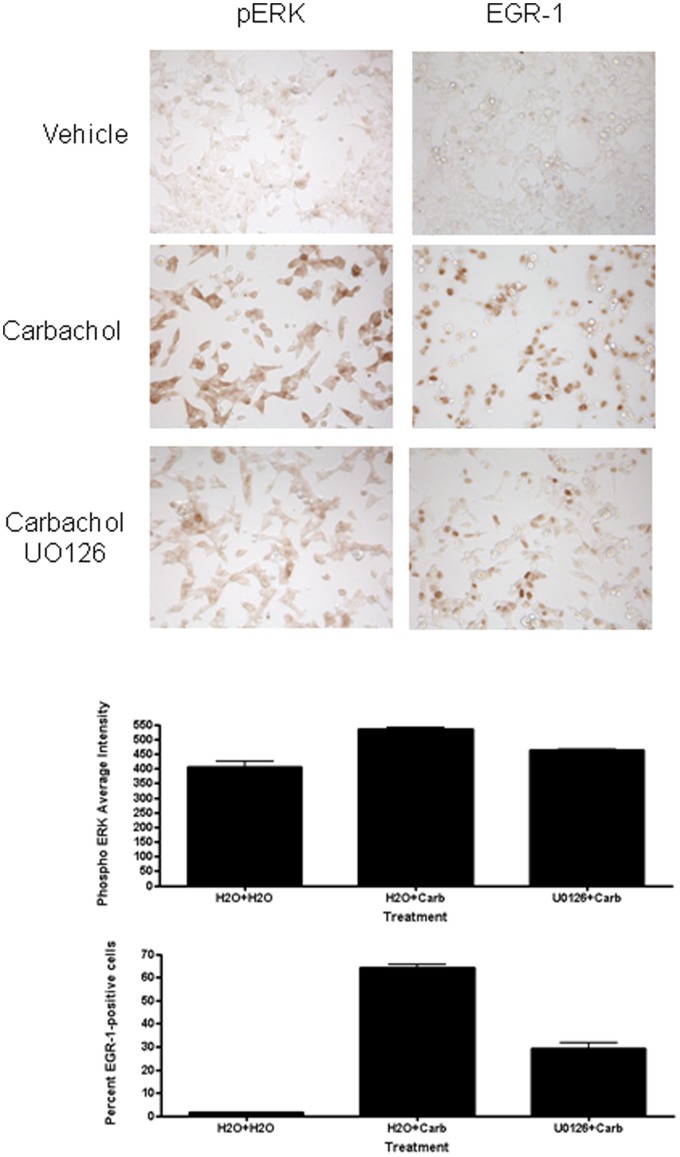
Activation of pERK and EGR-1 is still evident 24 hours following initial carbachol treatment.HEK293-M1 cells were stimulated for 24 h with vehicle or 100 µM carbachol as indicated. Then the cells were fixed and stained for pERK and EGR1. Note the high uniform activation of pERK and EGR-1. The lower panels show the effect of pretreatment (30 minutes) with 5 µM UO126, which shows that the aberrant signalling present at 24 h is independent of the MEK signalling pathway. Graphs show quantification of the induction and reversal of pERK and EGR-1 with U0126.